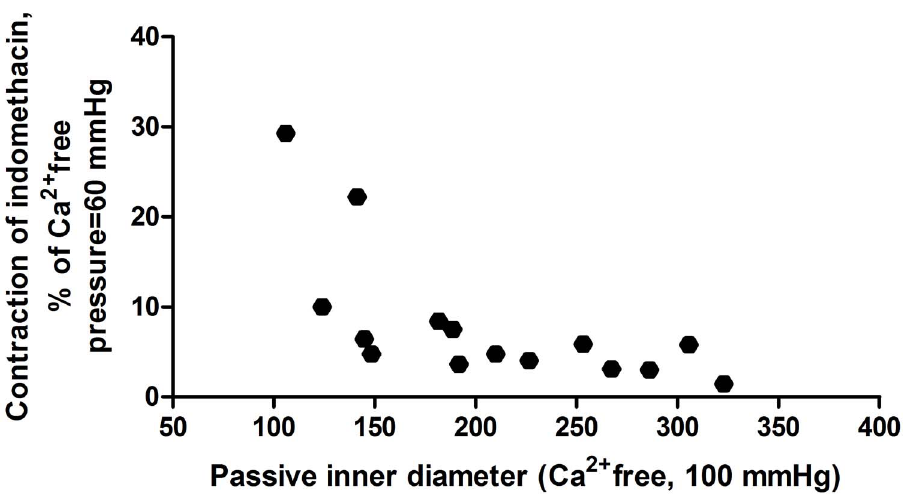
Figure 5. Correlation of indomethacin induced contraction on quercetin-dilated segments with the morphological lumen size. Note a more prominent contraction in smaller vessels (p , 0.05 with Pearson’s correlation).